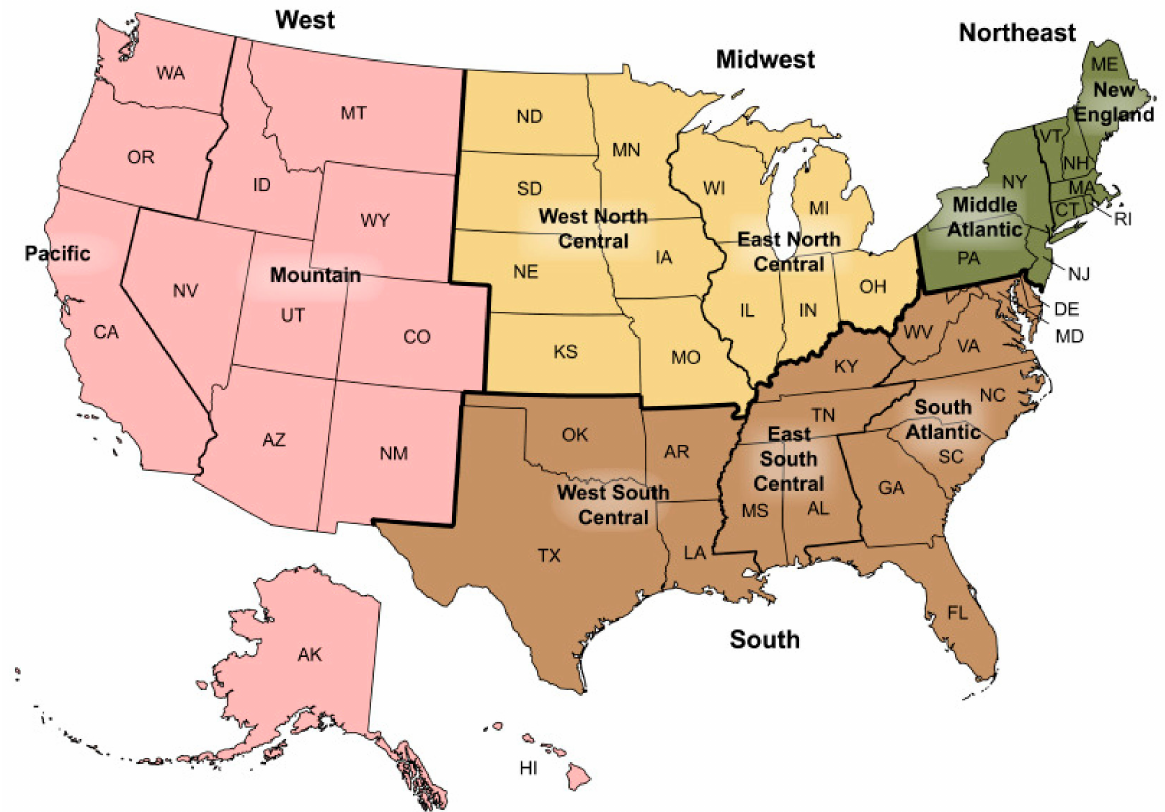
Figure 1. Regions of the United States, according to the US Census Bureau. The South Atlantic division comprises eight states and one district: Delaware, District of Columbia, Florida, Georgia, Maryland, North Carolina, South Carolina, Virginia, and West Virginia. The East South-Central division includes four states: Alabama, Kentucky, Mississippi, and Tennessee. Finally, the West South-Central division comprises Arkansas, Louisiana, Oklahoma, and Texas. In terms of agronomic characteristics, the southern region varies significantly across states. Notably, there is a strong north-south variation in average temperatures. The northwest reaches of the region, which include the states of Kentucky and West Virginia, include cold regions in USDA plant hardiness zone 6 ( − 23.3 to − 17.8 ◦ C), while the southern reaches of the region, which include the state of Florida, include warm regions in plant hardiness zone 11 (4.4 to 10 ◦ C). There is also